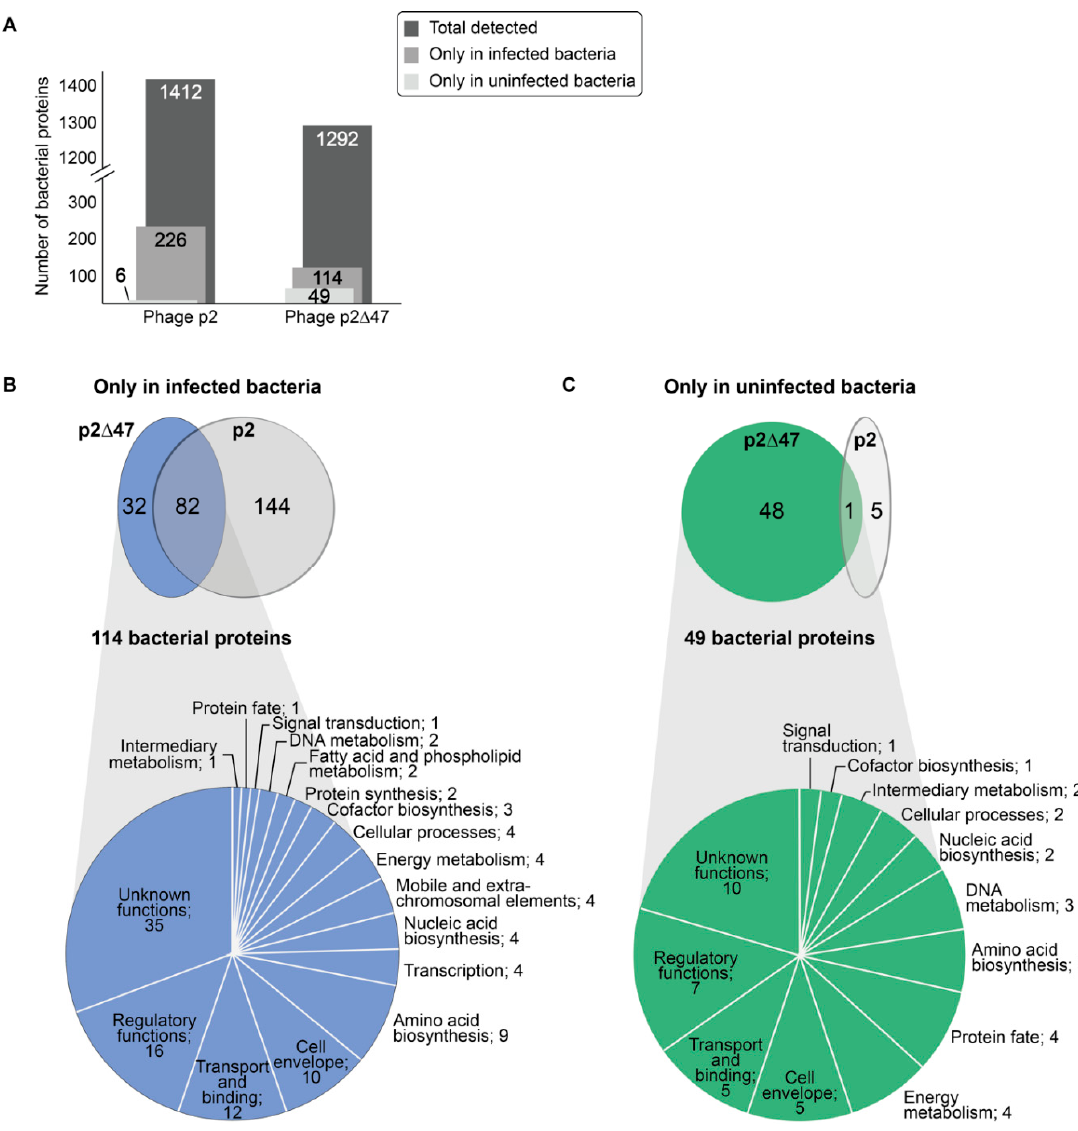
Figure 5. L. lactis MG1363 proteins identified during time-course infections by phage p2 and phage p2 ∆ 47. ( A ) Bar graph comparing the number of bacterial proteins detected during the infection of L. lactis MG1363 by either phage p2 or phage p2 ∆ 47. ( B ) Venn diagram depicting the overlaps of bacterial proteins identified strictly in infected cultures (not at T0) or ( C ) identified strictly in uninfected cultures (only at T0). Pie charts illustrate the proportion and the classification of these bacterial proteins according to their role(s) in metabolic pathways for the dataset generated with phage p2 ∆ 47. In ( B ) and ( C ), the number of proteins is indicated after the classification.